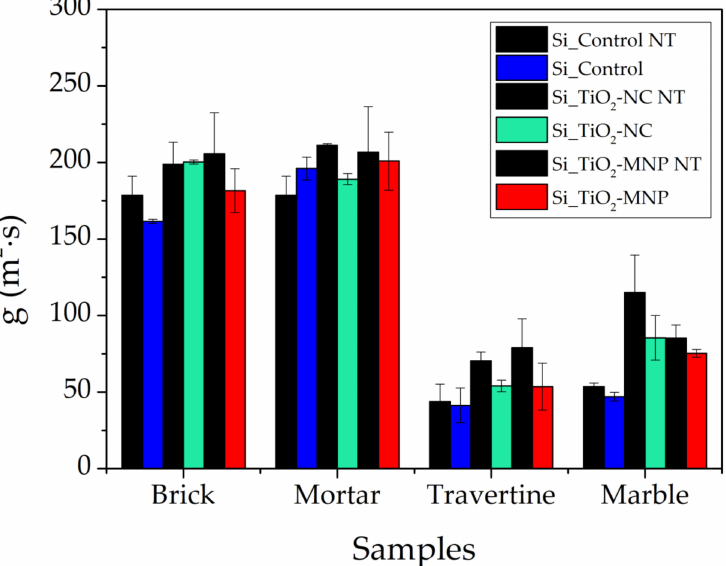
Figure 4. Mean water vapor permeability coefficient (g) shown for each stone before (black line on the left) and after (colored lines on the right) coatings application. The thin vertical black bar represents the mean standard